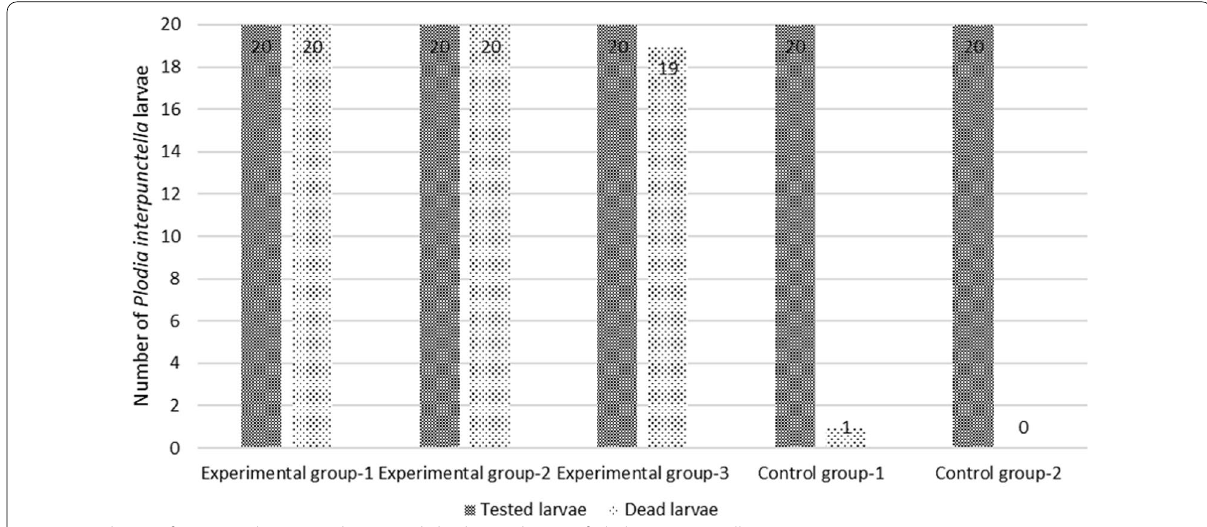
Fig. 5 Virulence of Mattesia dispora on the second/third instar larvae of Plodia